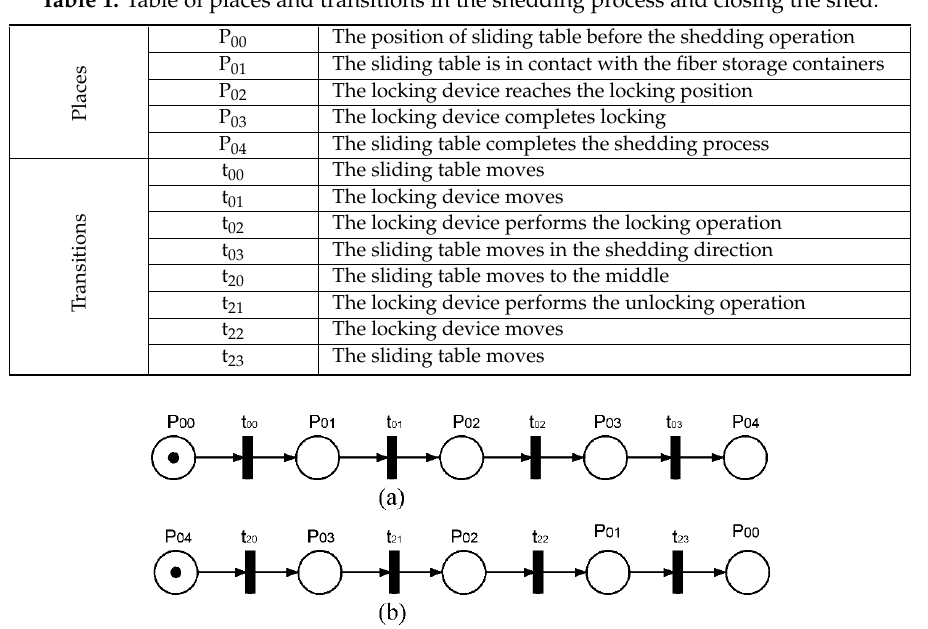
Figure 16. The Petri nets of the shedding process and closing the shed when the locking device and the sliding table move separately. ( a ) The net of transitions t 0 ; ( b ) the net of transitions t 2 .